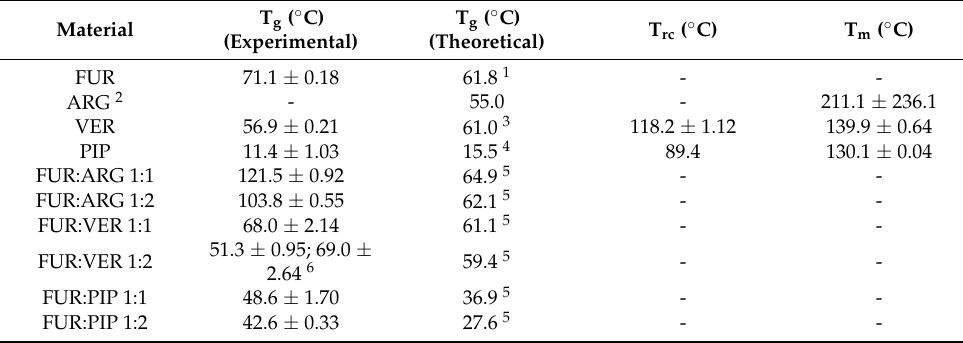
Table 1. Glass transition (T g ), recrystallization (T rc ) and melting (T m ) temperatures of furosemide (FUR), l- and d-arginine (ARG), verapamil hydrochloride (VER) and piperine (PIP) and their co- amorphous mixtures at 1:1 and 1:2 molar